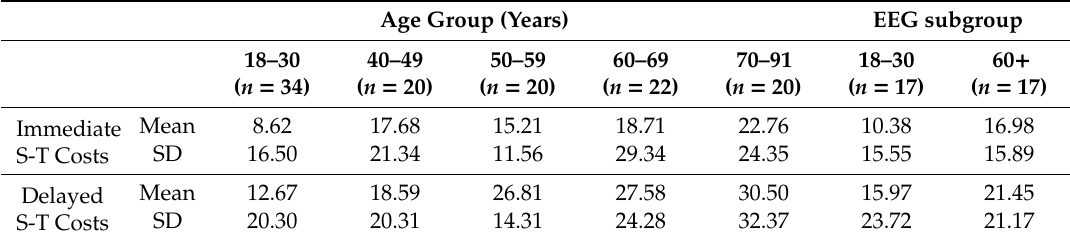
Table 2. Means and SDs of Sequential-Task Costs for each age